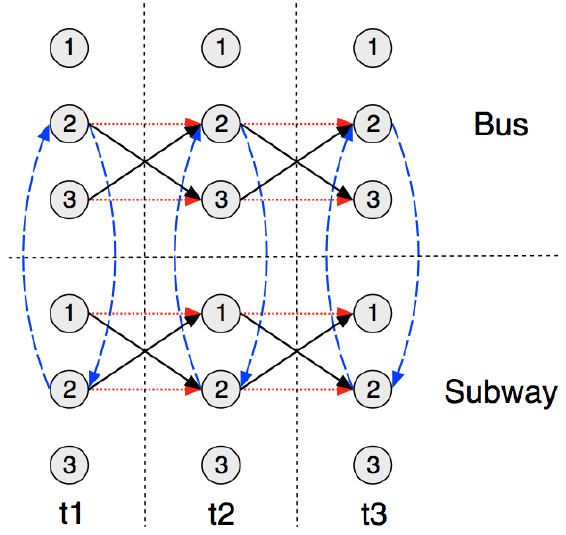
Figure 2. Illustrative MAG T of a hypothetical simple urban transit